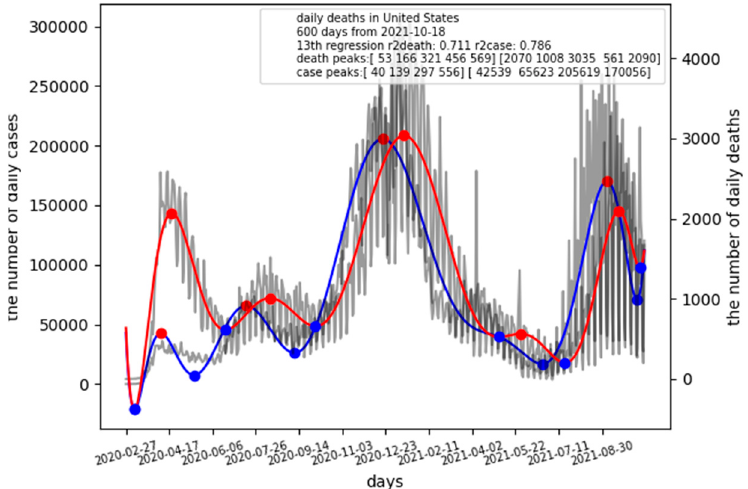
Figure 2. Case fatality rate and lag time in the United States as of 18 October